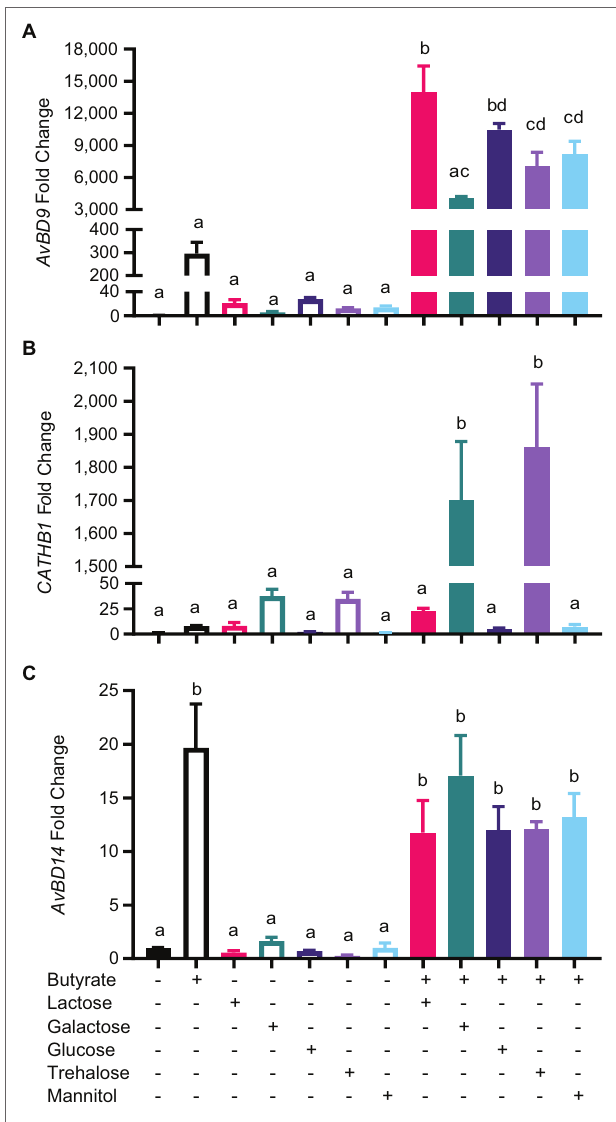
FIGURE 6 | Synergistic induction of HDP expression by butyrate and sugars. Chicken HD11 cells were stimulated in duplicate with 2 mM butyrate and 0.2 M of indicated sugars separately or in combination for 12 h, followed by RNA isolation and RT-qPCR analysis of the mRNA expression levels of AvBD9 (A) , CATHB1 (B) , and AvBD14 (C) . Results are expressed as means ± SEM of 2–3 independent experiments. The bars without common superscript letters denote statistical significance ( p < 0.05) as determined by one-way ANOVA and post hoc Tukey’s